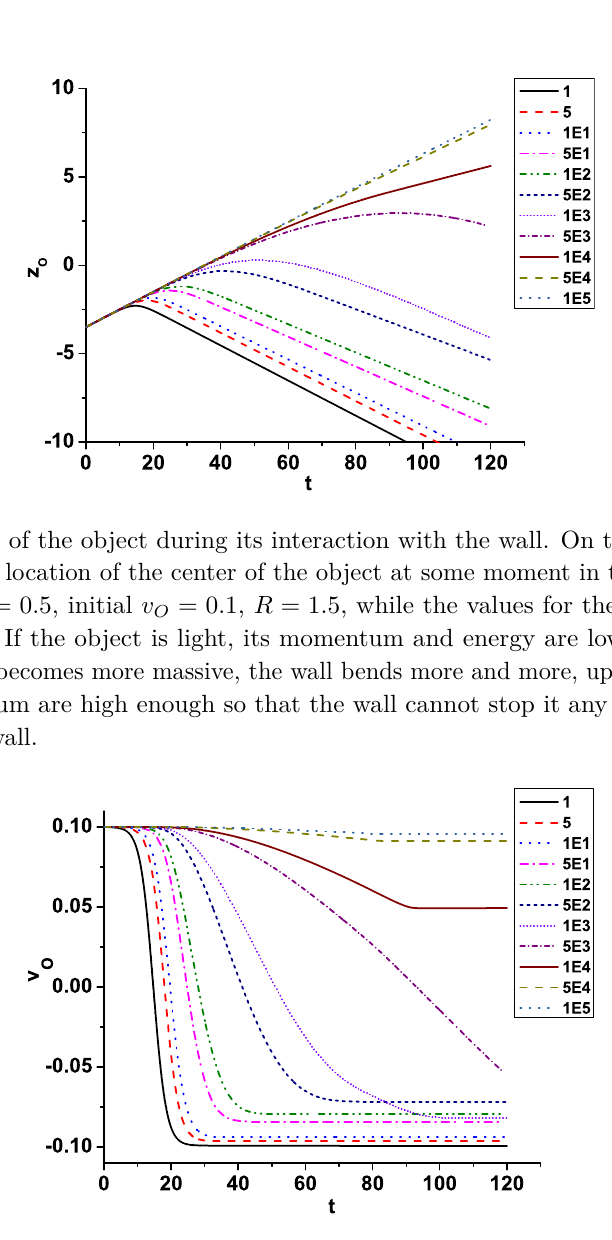
Figure 4 . Evolution of the velocity of the object, v O , during the collision with the wall as a function of time. The parameters are chosen to be A = 0 . 5 , initial v O = 0 . 1 , R = 1 . 5 , while the values for the object’s mass m are marked in the plot. A very light object is bounced back (velocity is reversed) without any energy loss nor gain. Medium mass objects are reflected by the wall, but they also gain some wall distortion energy back during the collision. In these cases the wall acts like a spring. Therefore their velocity can be larger than in some of the lighter cases. Very massive objects pass through the wall and cannot gain the distortion energy back, so they lose the highest amount of